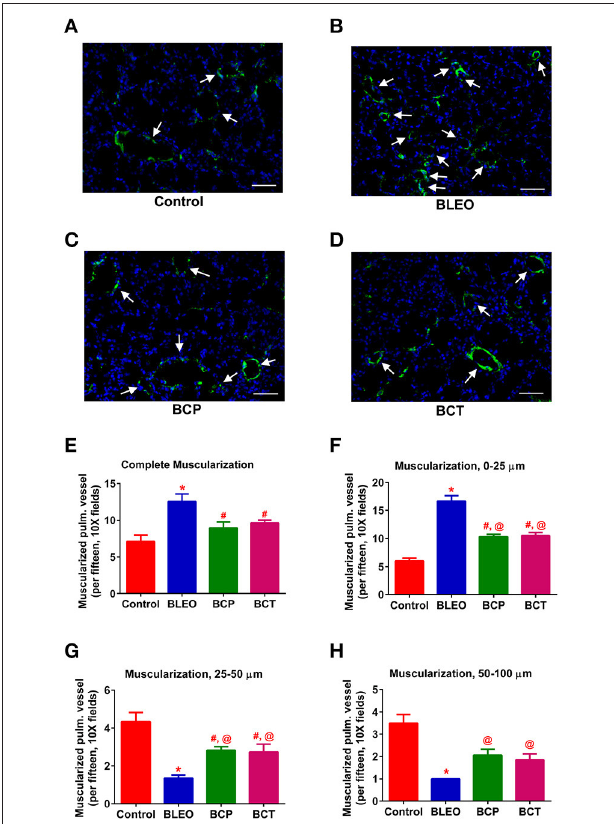
FIGURE 4 | C21 treatment attenuates pulmonary vascular remodeling in BLEO animals. (A–D) Representative images of α -smooth muscle actin stained pulmonary vessel wall (white arrows). (E–H) Summary data showing the improvement of muscularization by C21 in BLEO animals for the complete, 0–25, 25–50, and 50–100 µ m category, respectively. Data represented in (E–H) are mean ± SEM ( n = 3). *Indicates a p -value of ≤ 0.05, comparing BLEO animals against the controls. # Indicates a p -value of ≤ 0.05, comparing BCP and BCT vs. BLEO. @ indicates a p -value of ≤ 0.05, comparing BCP and BCT vs. control. Scale = 50 µ